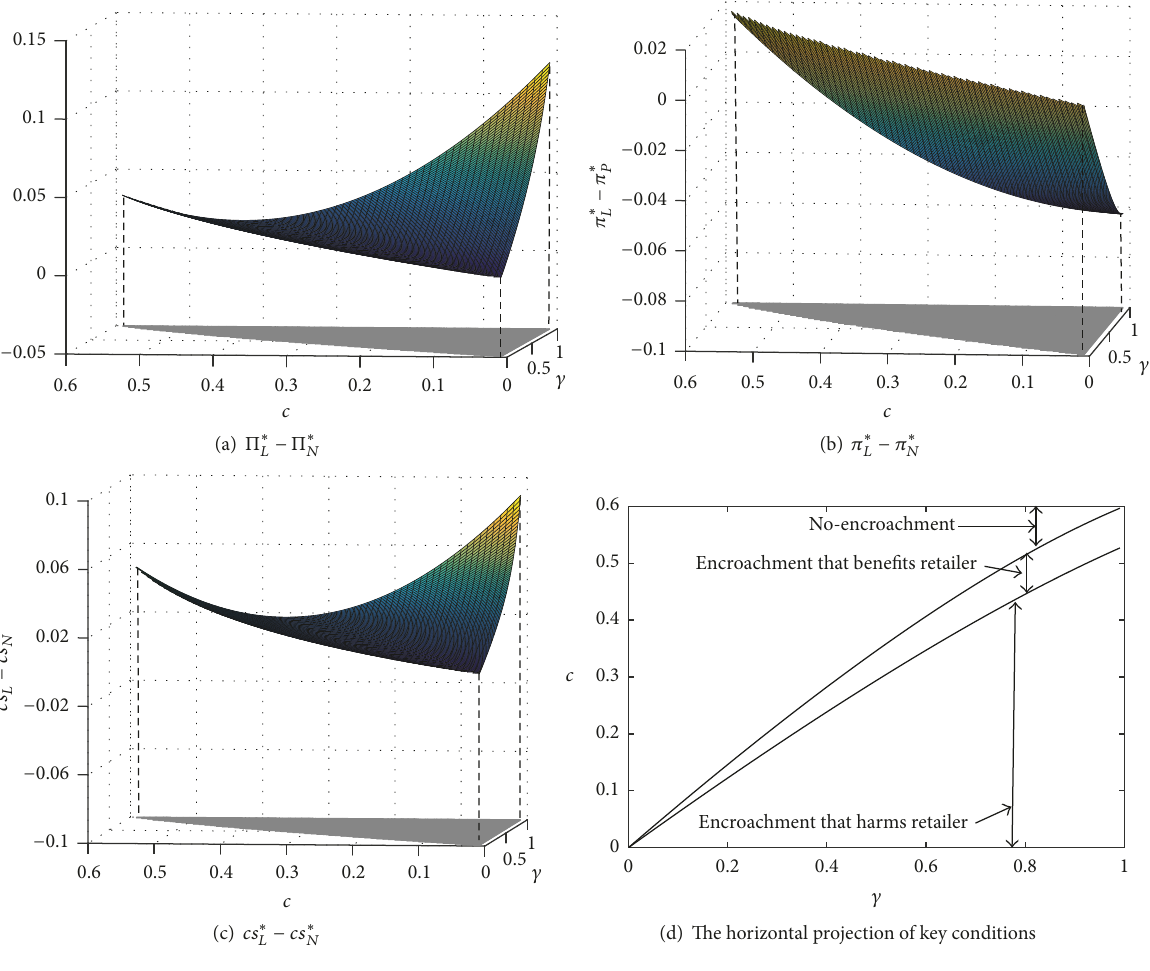
(d) The horizontal projection of key conditions Figure 3: Key conditions of Model 𝐿